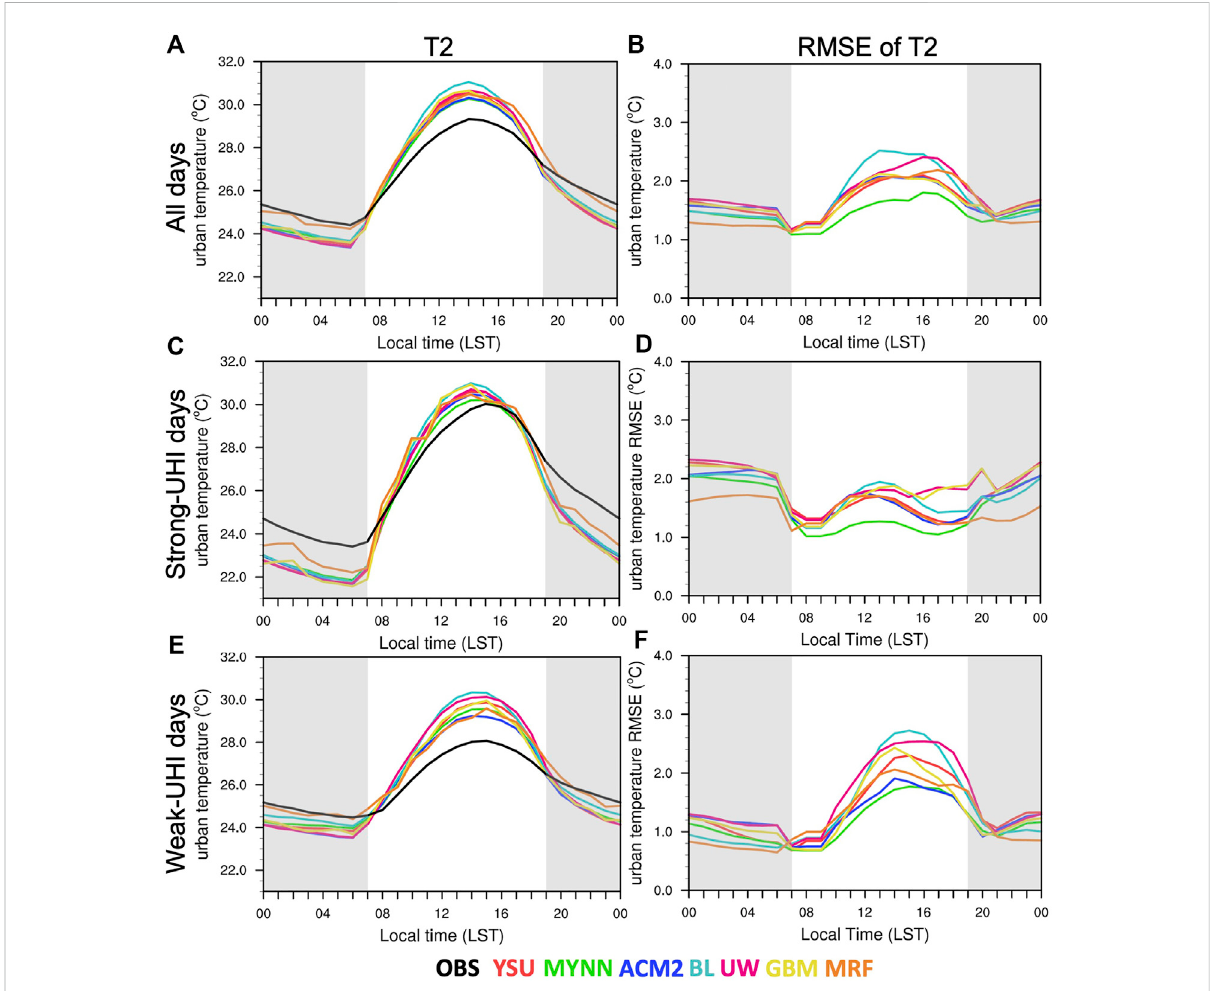
FIGURE 7 (A) Comparisons of the observed and simulated diurnal variations in the domain-averaged near-surface temperature for the entire early summerrainyseason(excludingthedayswhenTCsmadelandfall)and (B) thecorrespondingrootmeansquareerrorofthemodel. (C,D) and (E,F) are similar to (A,B) but for the strong- and weak-UHI days. The gray zones denote the nocturnal time window from 1900 LST to 0700